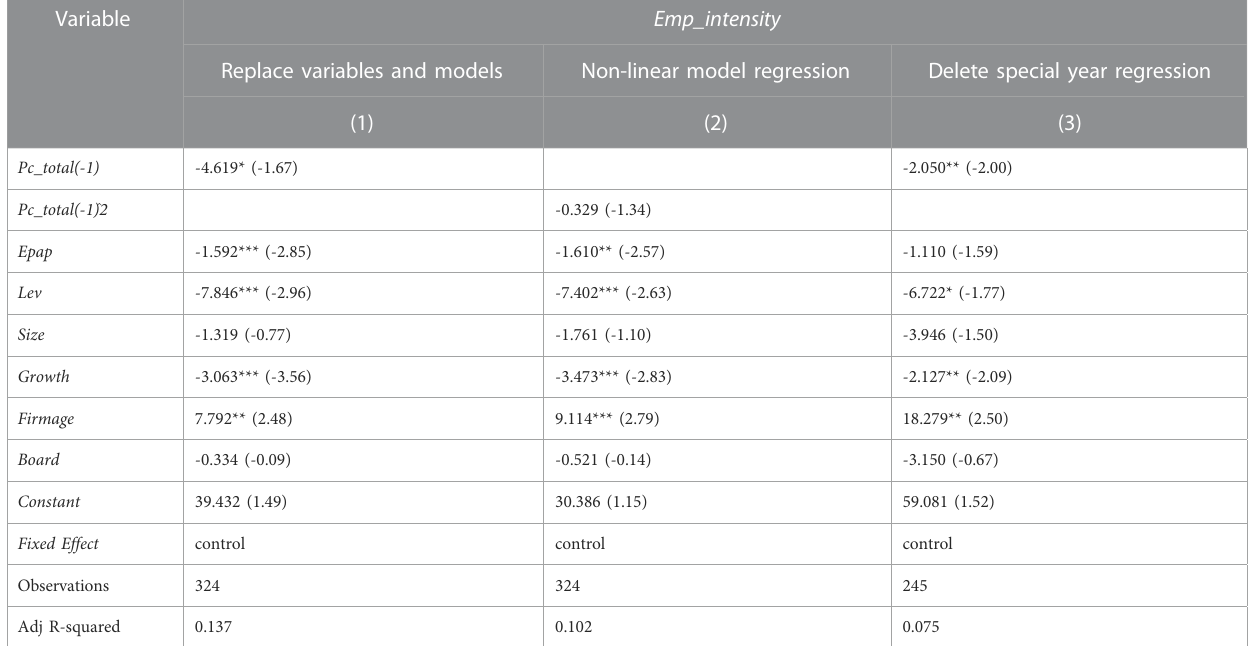
TABLE 7 Robustness test